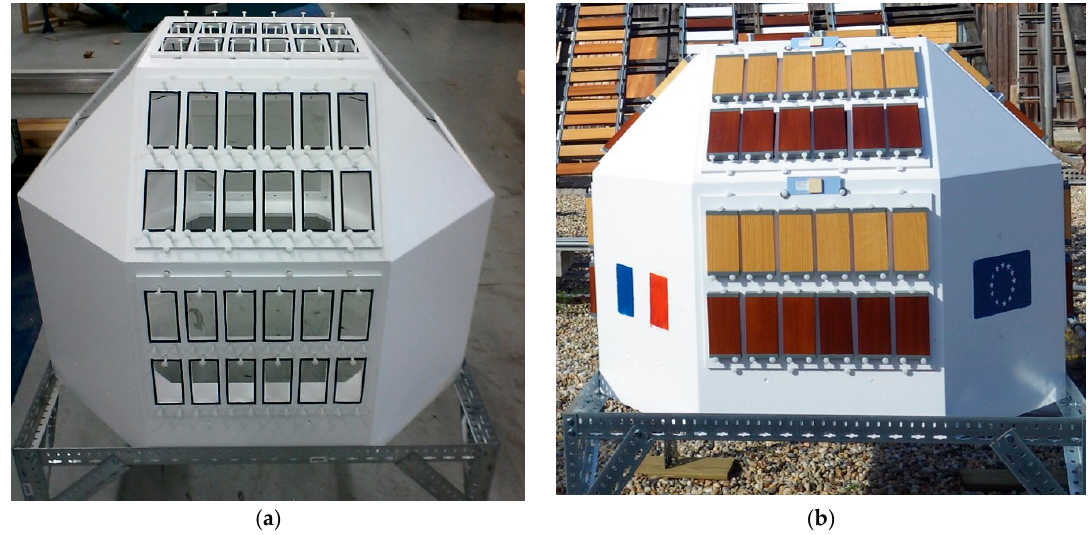
Figure 1. The multifaceted exposure rig (MFER) without ( a ) and with samples ( b ).